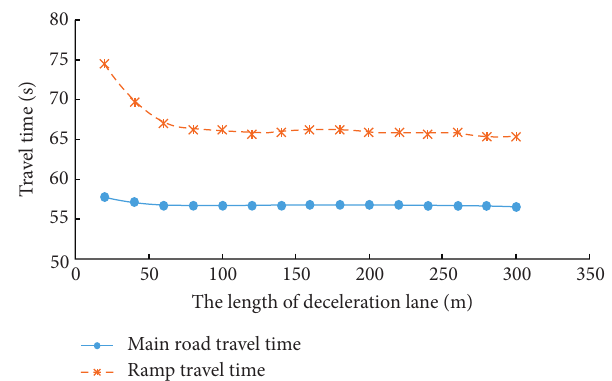
Figure 5: The relationship between travel time and the length of the acceleration lane.